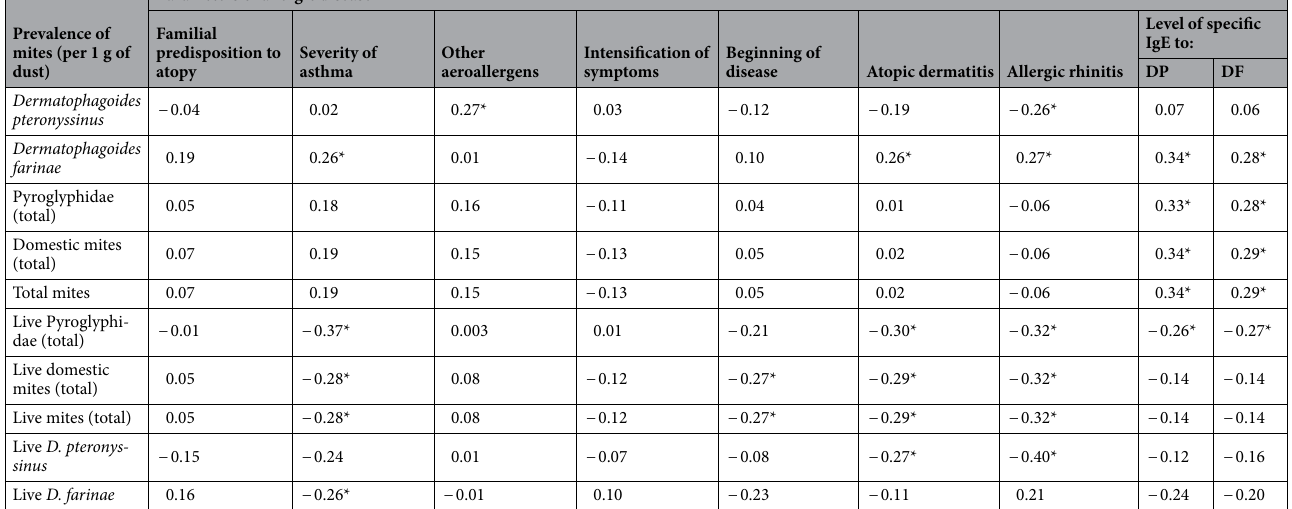
Table 6. Correlations observed between parameters of allergic disease and the prevalence of mites in dust samples from dwellings of the examined patients in Bytom (south Poland). Results of the Spearman’s rank correlation test analysis (*p < 0.05). Familial predisposition to atopy: yes [1], no [0]; Severity of asthma: seasonal [1], moderate [2], severe [3]; Other aeroallergens (scores of skin tests): positive [1], negative